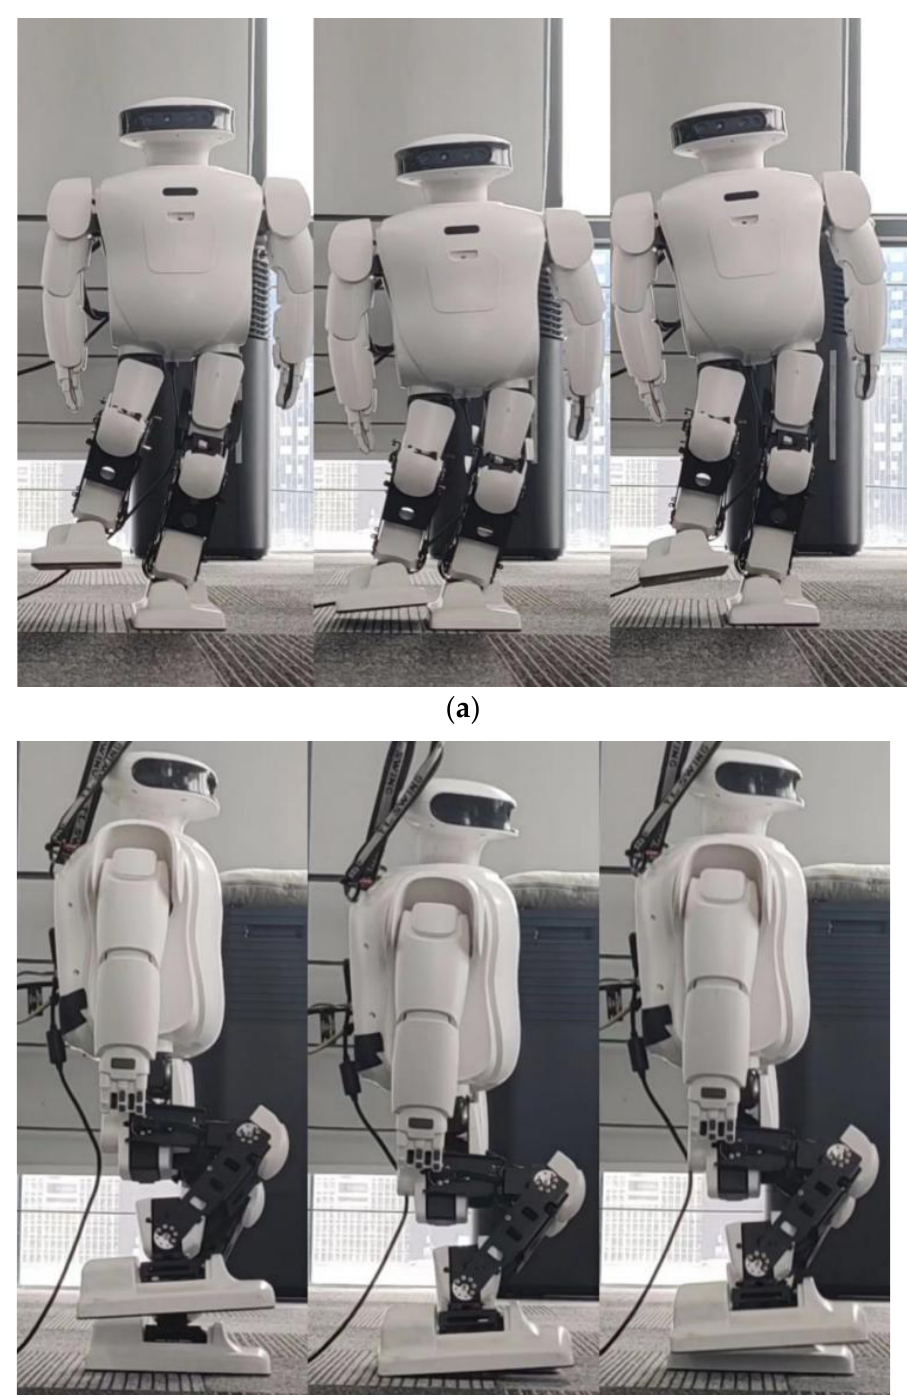
Figure 19. When Roban’s COM moves 5 cm, it completes three squats on a single leg at twice the speed. ( a ) A main view of the robot squatting process at twice the speed. ( b ) A side view of the robot squatting process at twice the speed. Compared with the Figures 19 and 20, the motion effect of the robot becomes better. We again note the roll and pitch angle curves between